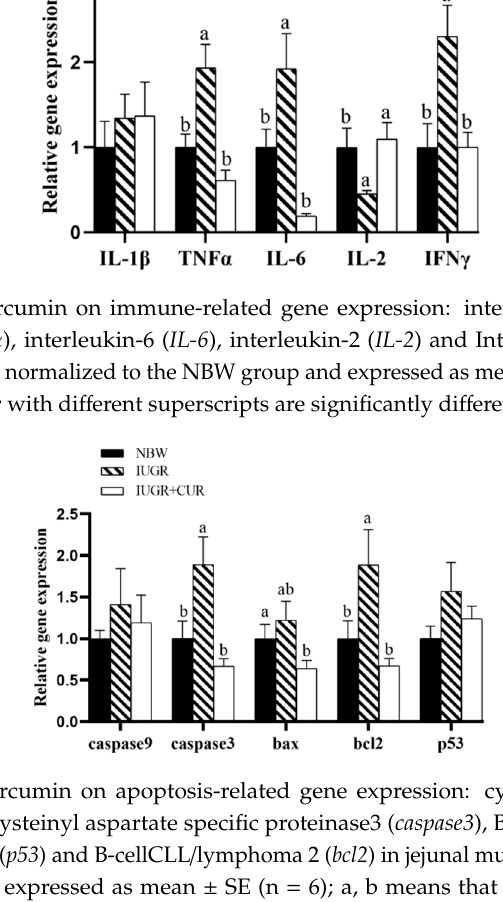
Figure 3. Effects of curcumin on immune-related gene expression: interleukin-1 β ( IL-1 β ), tumor